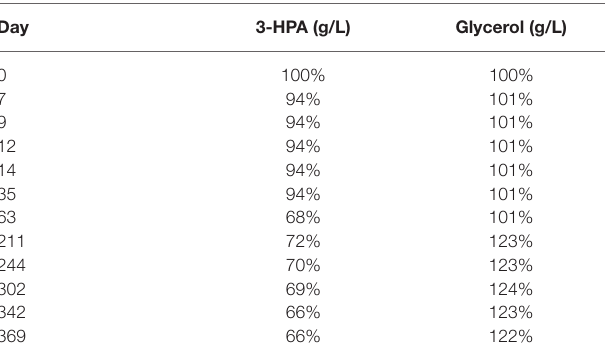
TABLE 2 | Average content of 3-HPA and glycerol in the supernatant (in % of the initial value) of the two samples from bioreactor 1 examined at different time points after storage at − 20 ° C.